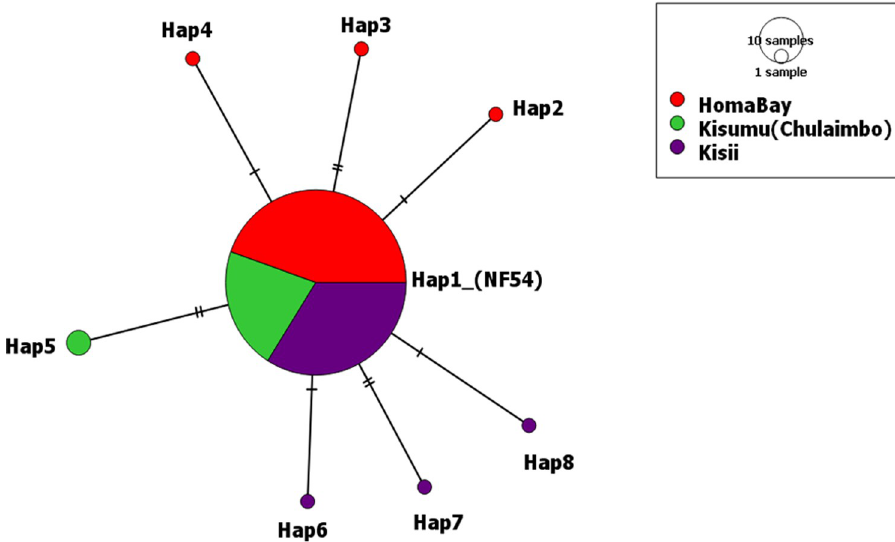
Fig 3. TCS-network analysis of the relationship of Pfs25 haplotypes in malaria-endemic and epidemic-prone regions of western Kenya. The network shows the distribution of haplotype within malaria-endemic lowlands of Homa Bay (red) and Kisumu (Chulaimbo) (green) as well as Kisii highlands (purple). The hatch marks represent the number of mutations (double hatch marks equate to two polymorphic sites) whereas the size of the circle equate to the relative frequency of haplotypes. Hap 1 (lacked mutated site, identical with Pfs25 reference sequence of NF54 strain or 3D7 strain), Hap2 (had codon change L42M), Hap3 (H41H and T124T), Hap4 (C110C), Hap5 (T130T and V132I), Hap6 (I83I), Hap7 (C115W) and Hap8 (L122L,